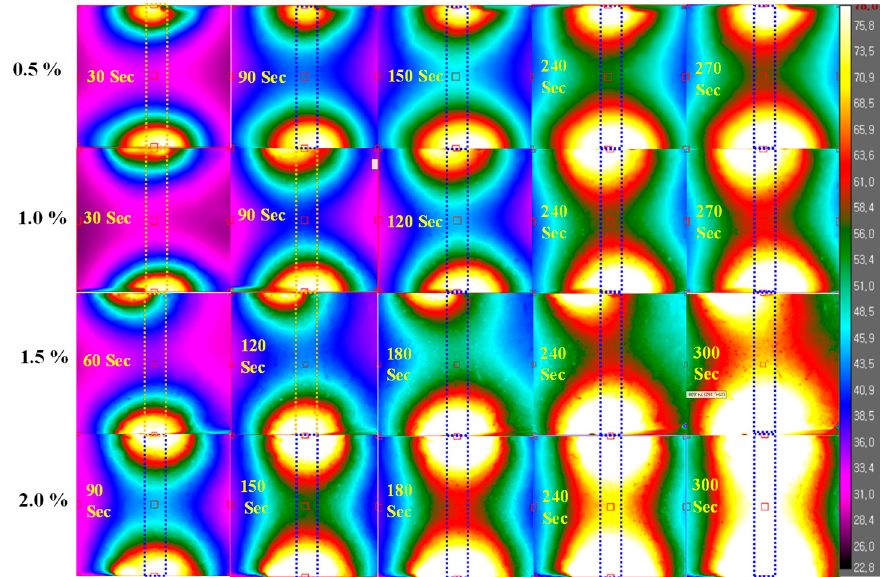
Figure 5. Heat/Temperature distribution patterns of a prism set. The dotted vertical rectangle and the time in each temperature distribution represent the surface area of the minimum volume and the heating time, respectively.